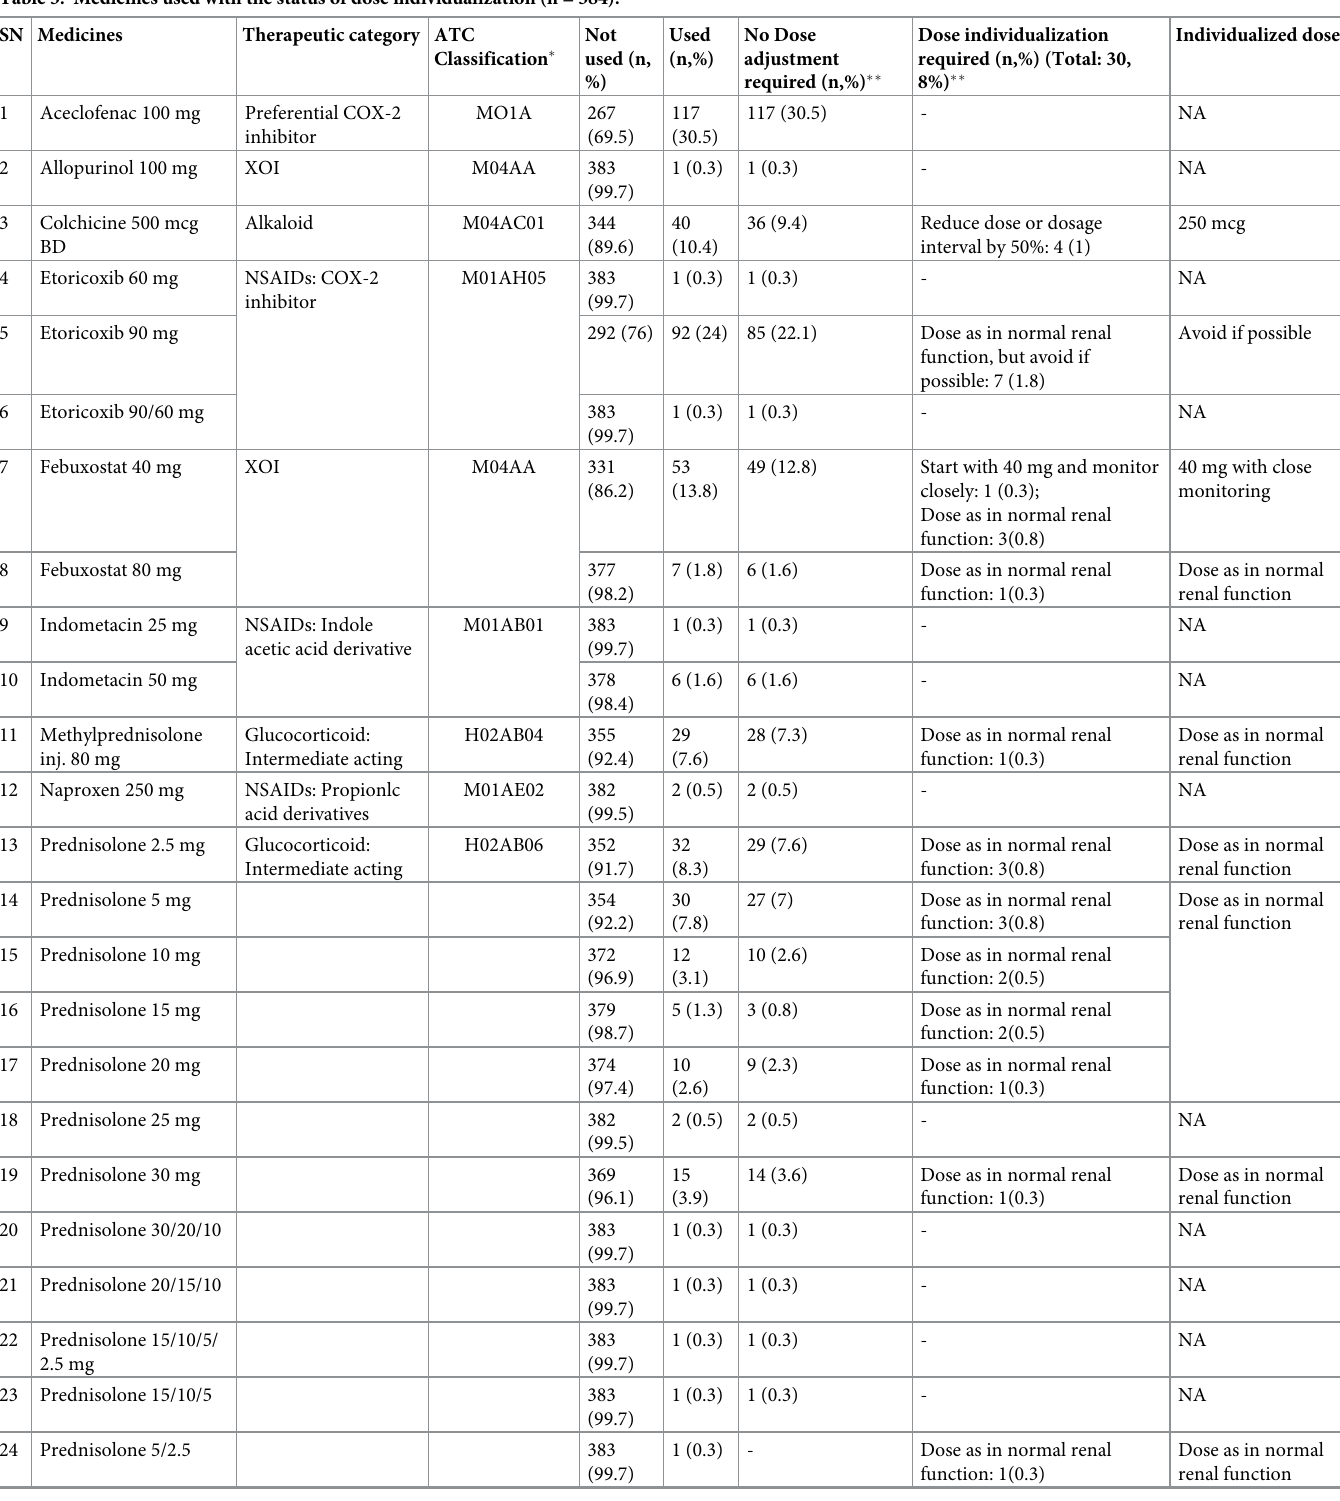
Table 3. Medicines used with the status of dose individualization (n =